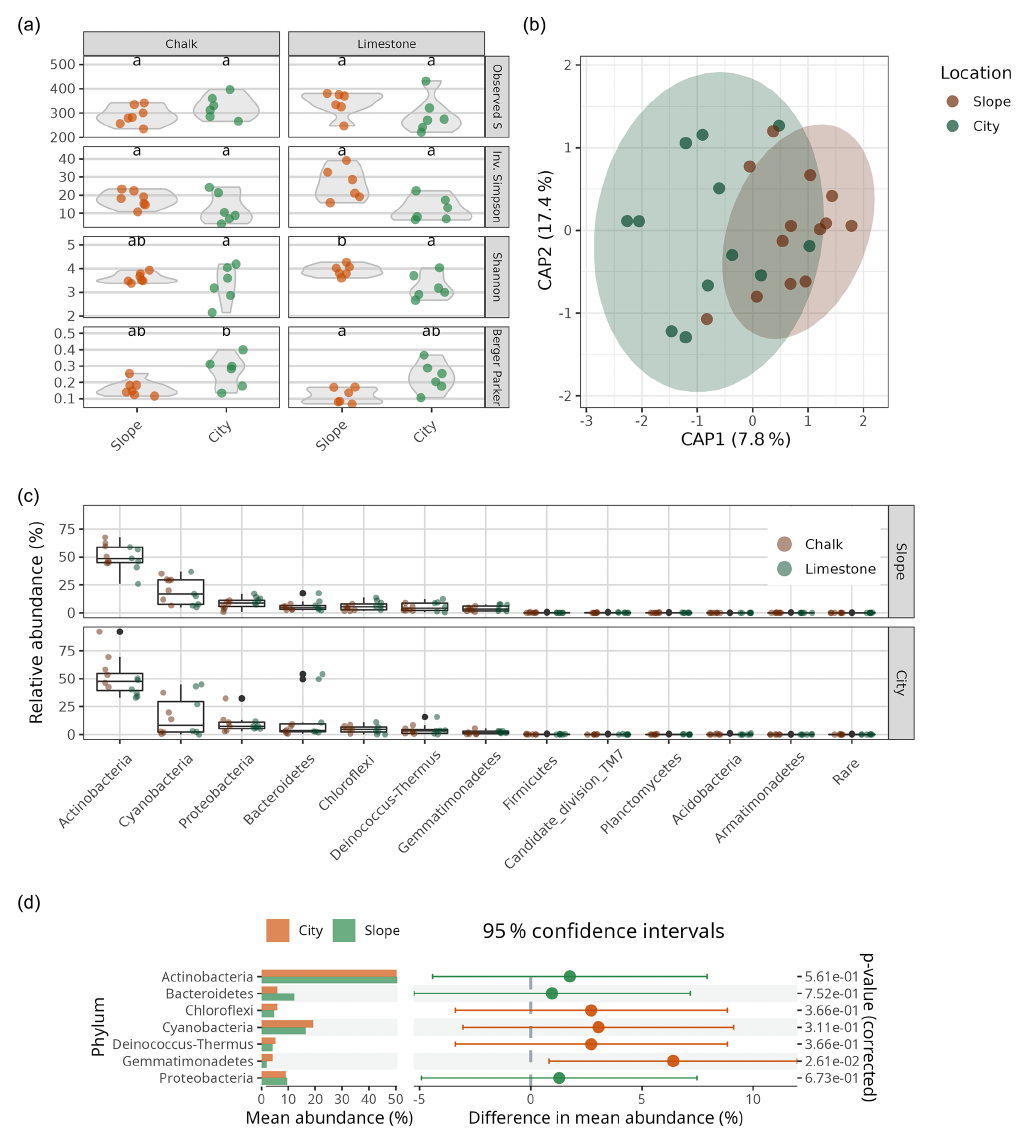
Figure 4. (a) Bacterial alpha-diversity indices (Observed S, Inv. Simpson, Shannon’s H and Berger–Parker) for chalk and limestone BRCs. Different lowercase letters denote statistical difference at P < 0 . 05. (b) Canonical analysis of principal (CAP; i.e. constrained principal- coordinates analysis) showing the differences in bacterial community composition in limestone and chalk BRCs collected from the city and nearby slopes ( n = 24). The numbers in brackets indicate the explained variance in the constrained model (Morisita–Horn distance as a function of location). (c) Bacterial community composition in the chalk and limestone BRCs sampled from the Byzantine city of Shivta and adjacent slopes. “Rare” denotes all OTUs belonging to phyla that account for less than 5% of the combined relative abundance. (d) Differences in mean abundance, 95% confidence intervals and statistical significance (based on ART ANOVA) on the phylum level between slope and city samples (only phyla that account for more than 5% of the relative abundance are